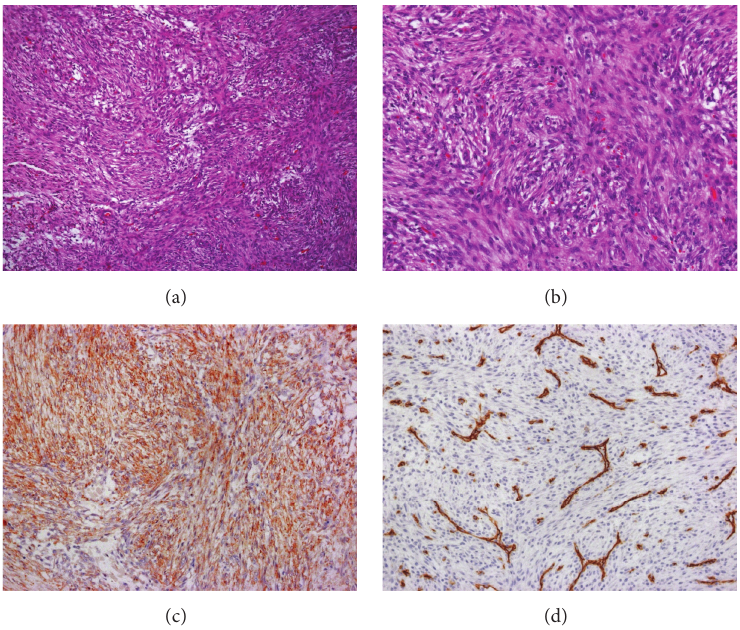
Figure 2: (a) Proliferation of spindle cells arranged in fascicles (Hematoxylin and Eosin stain, original magnification 10x). (b) Cells of nodular fasciitis with elongated shape, oval nuclei, and eosinophilic cytoplasm (Hematoxylin and Eosin stain, original magnification 40x). (c) Immunohistochemical stain showing strong positivity for smooth muscle actin (smooth muscle actin stain, original magnification 20x). (d) Immunohistochemistry stain showing negativity for CD34 (CD34 stain, original magnification